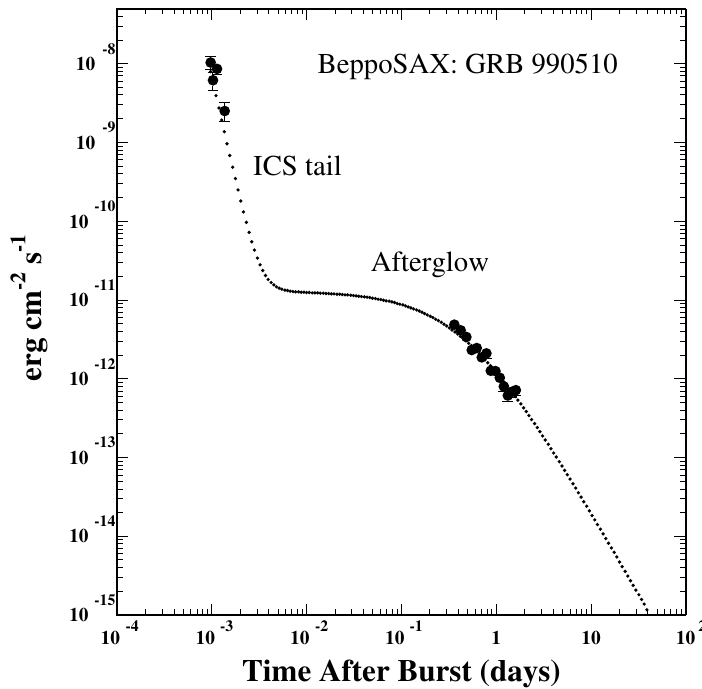
Figure 10. The X-ray afterglow of GRB 990510 measured with the telescopes aboard the BeppoSAX satellite compared to the canonical X-ray afterglow predicted by the CB model [57,91] of SN-GRBs.